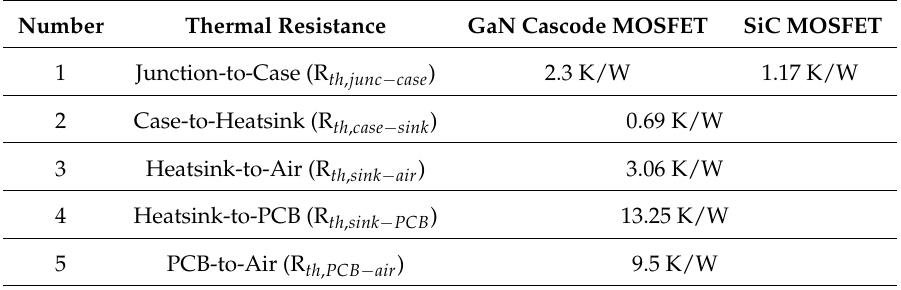
Table 1. The extracted or calculated values of the thermal resistances used in the 1-D steady state Foster network of Figure 1b for both wide-bandgap devices.